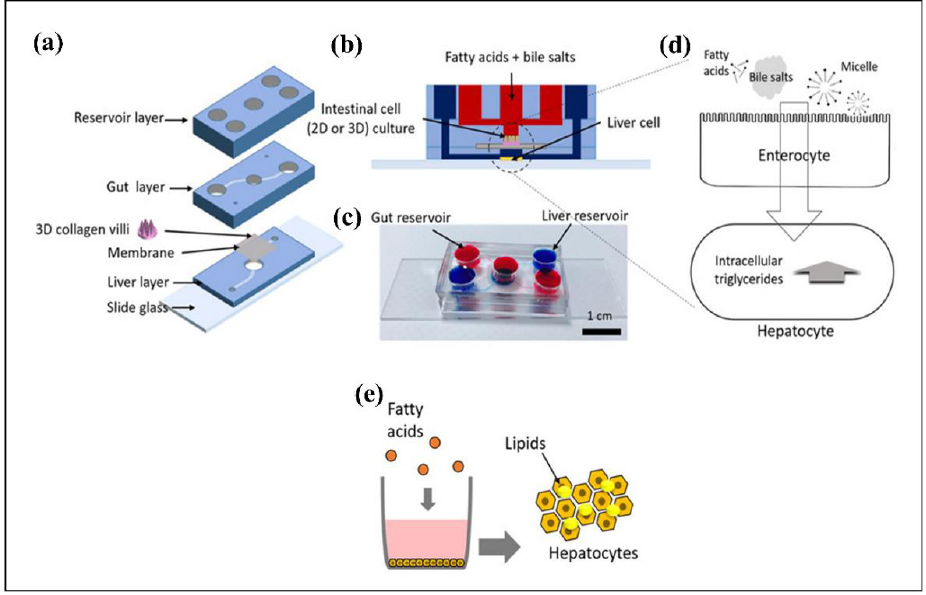
Figure 14. A schematic of gut-liver chip presented by Lee et al. to recapitulate hepatic steatosis. ( a ) Representative figure of gut-liver chip, indicating gut layer top of the membrane and liver layer on the bottom of the membrane. ( b ) Cross-section of the gut-liver chip. ( c ) An image of an assembled gut-liver chip (blue ink indicates the liver part, whereas red ink indicates the gut part). ( d ) This figure shows that absorption of fatty acids by gut cells (enterocytes) and liver cells (hepatocytes) in the gut – liver platform. ( e ) This illustration demonstrates a lipid accumulation experiment in a microwell plate. Cultured hepatocytes (HepG2) in a well plate were exposed to lipid accumulation, and quantification of lipid accumulation was performed. Reprinted with permission from ref. [383],